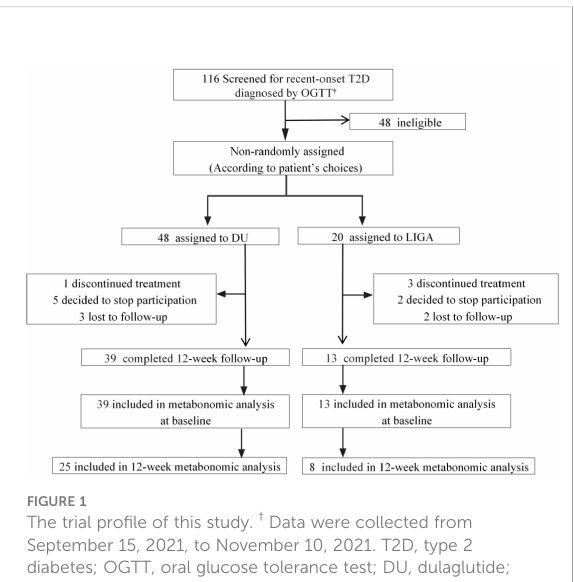
FIGURE 1 The trial pro fi le of this study. † Data were collected from September 15, 2021, to November 10, 2021. T2D, type 2 diabetes; OGTT, oral glucose tolerance test; DU, dulaglutide; LIGA,